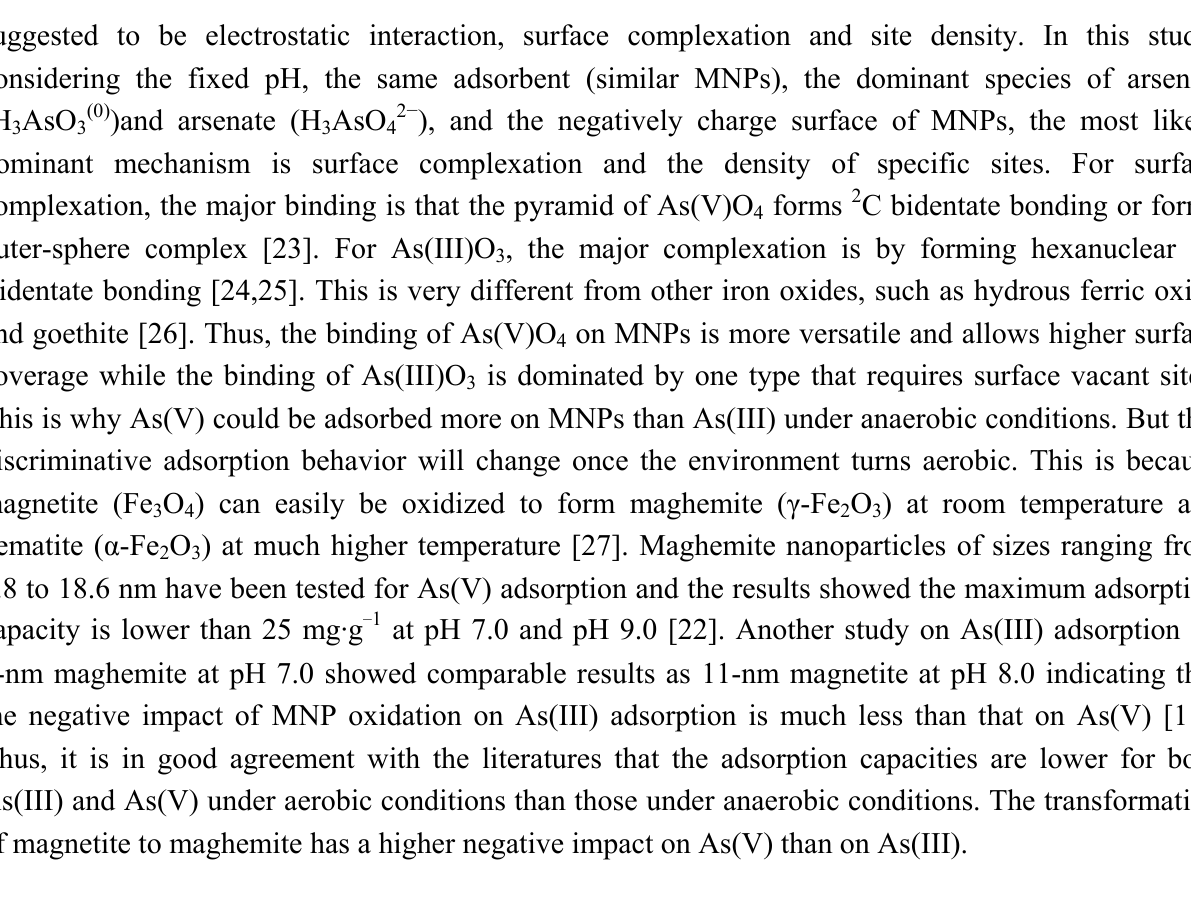
Table 1. Comparison of the adsorption capacity of different iron oxide on As(III) and As (V).